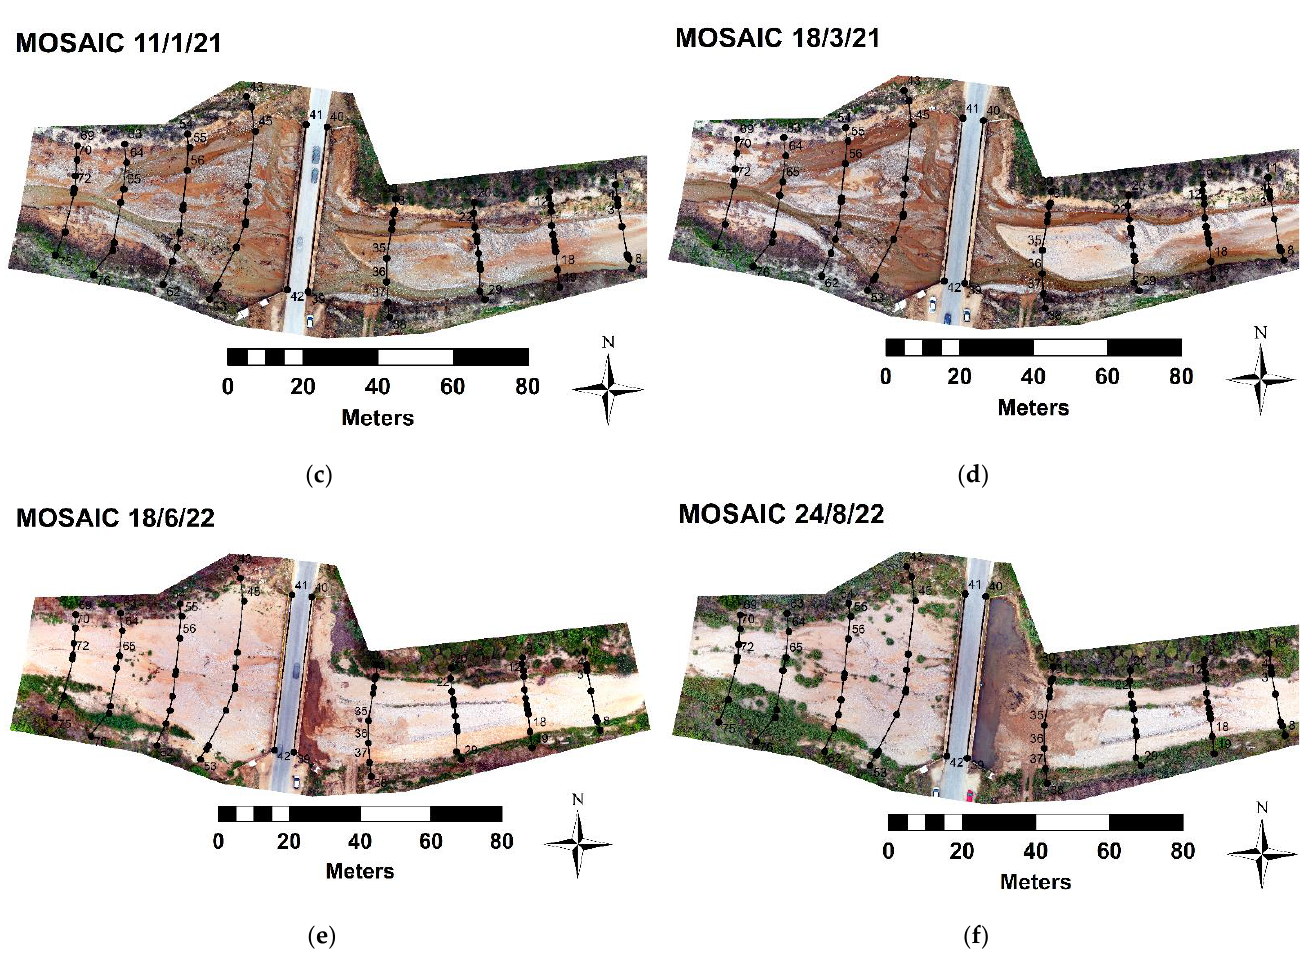
Figure 6. The produced orthomosaic for each UAV flight: ( a ) 24 September 2020, ( b ) 5 January 2021, ( c ) 11 January 2021, ( d ) 18 March 2021, ( e ) 18 June 2022 and ( f ) 24 August 2022. In addition, the field cross-section survey based on the GPS/GNSS is also depicted in each orthomosaic.